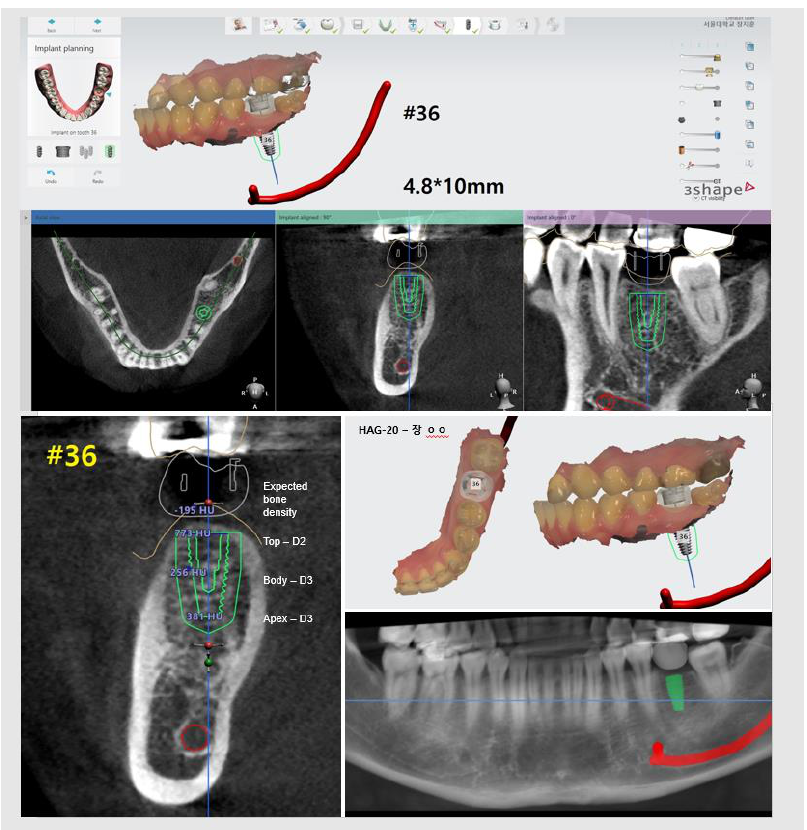
Figure 2. Patient-specific analytical procedures including the virtual implant position and